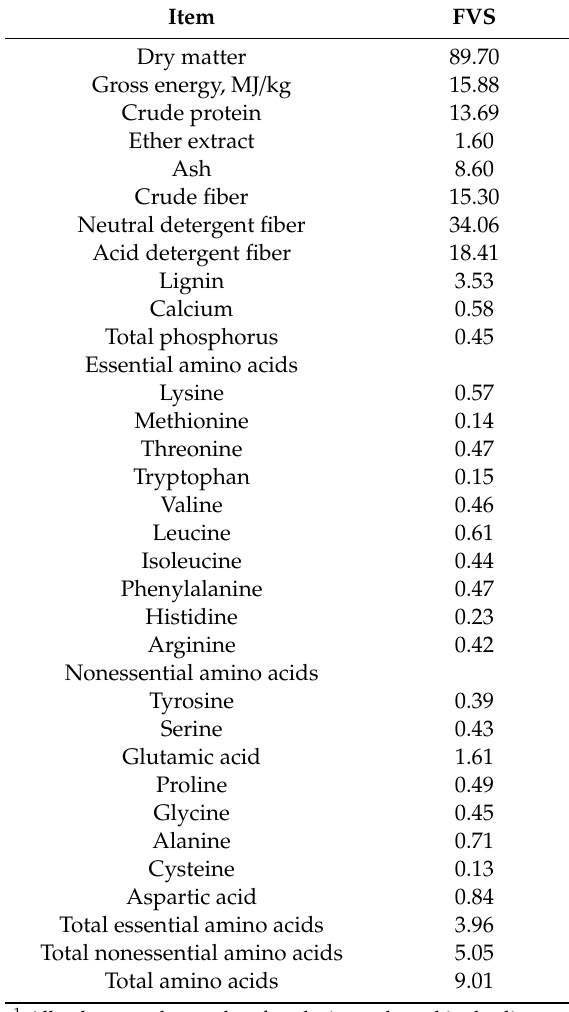
Table 1. Analyzed chemical compositions of Flammulina velutipes stem waste (FVS) (%, as-fed basis, unless otherwise indicated) 1